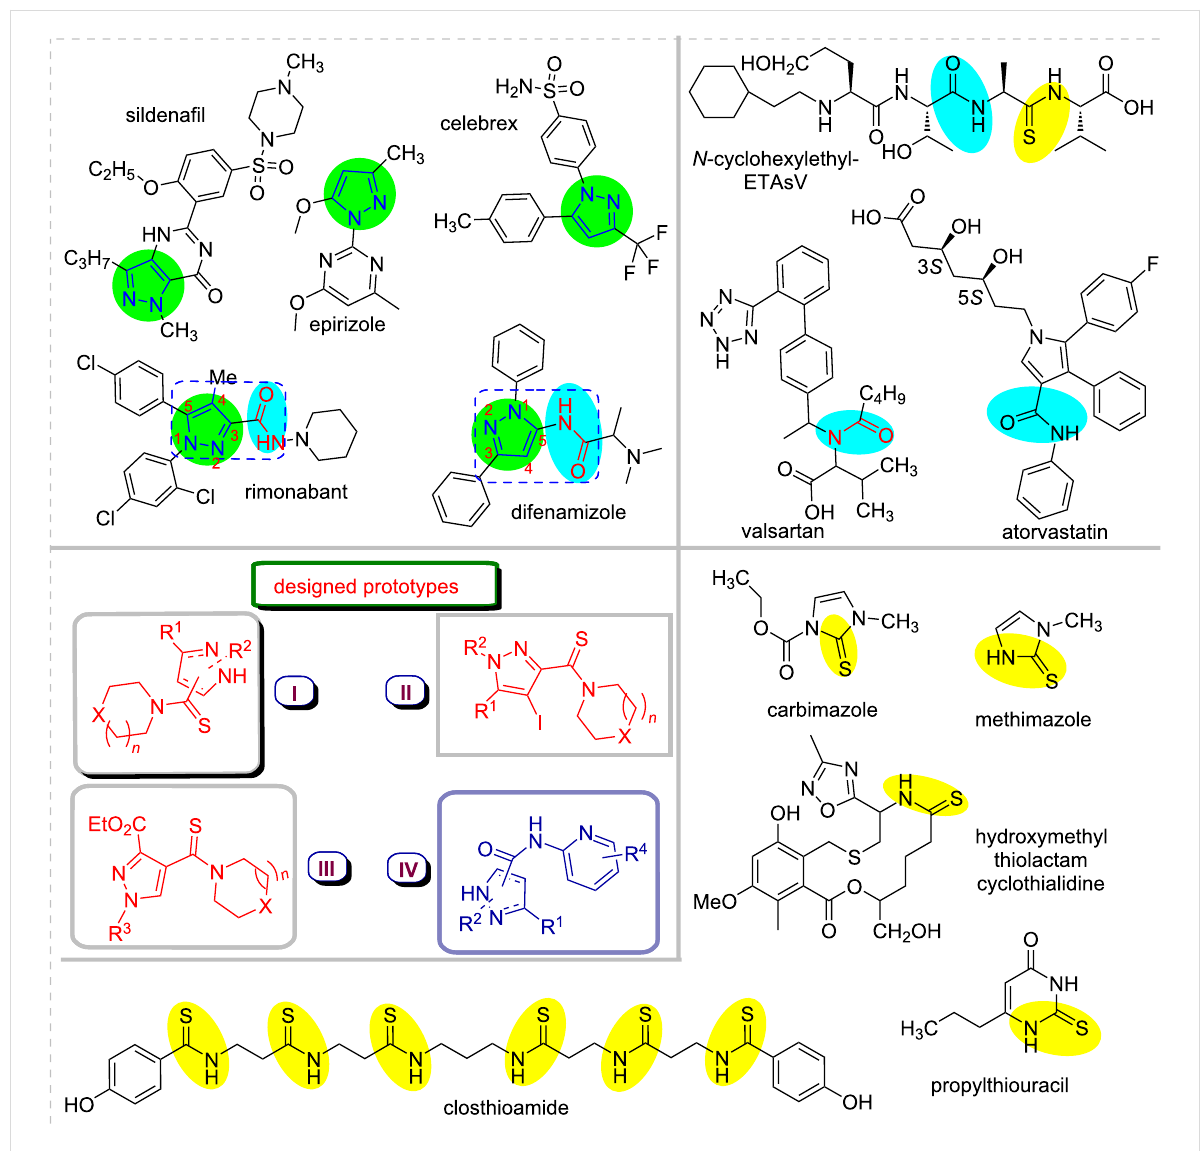
Figure 1: Representative drug molecules based on pyrazole, thioamide, and amide